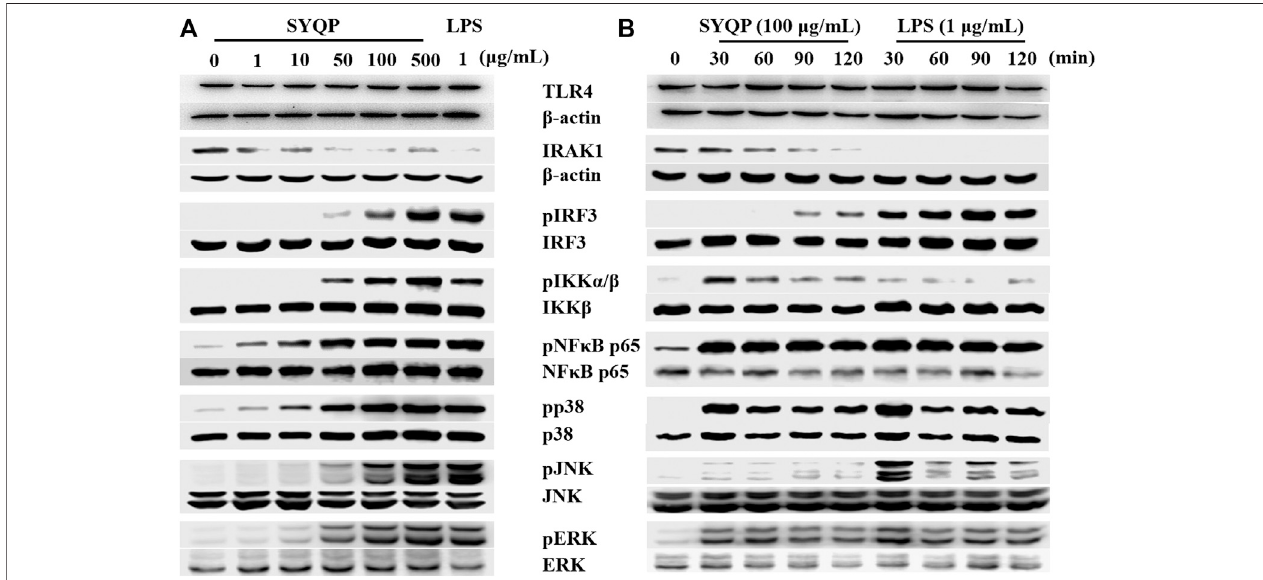
FIGURE 4 | SYQP activated pathways downstream of TLR4 without selection. (A) RAW264.7 cells were treated with 1 – 500 μ g/ml SYQP or 1 μ g/ml LPS for 2 h (TLR4,IRAK1,IRF3)or30 min(IKK,NF- κ B,p38,JNKandERK). (B) RAW264.7cellsweretreatedwith100 μ g/mlSYQPor1 μ g/mlLPSfortheindicatedtimepoints.The expression of molecules in the TLR4 pathways was determined by western blot analysis. The blot shown is a representative of one of three similar experiments. The densitometric analysis of the protein expression was shown in Supplementary Figure S2 .